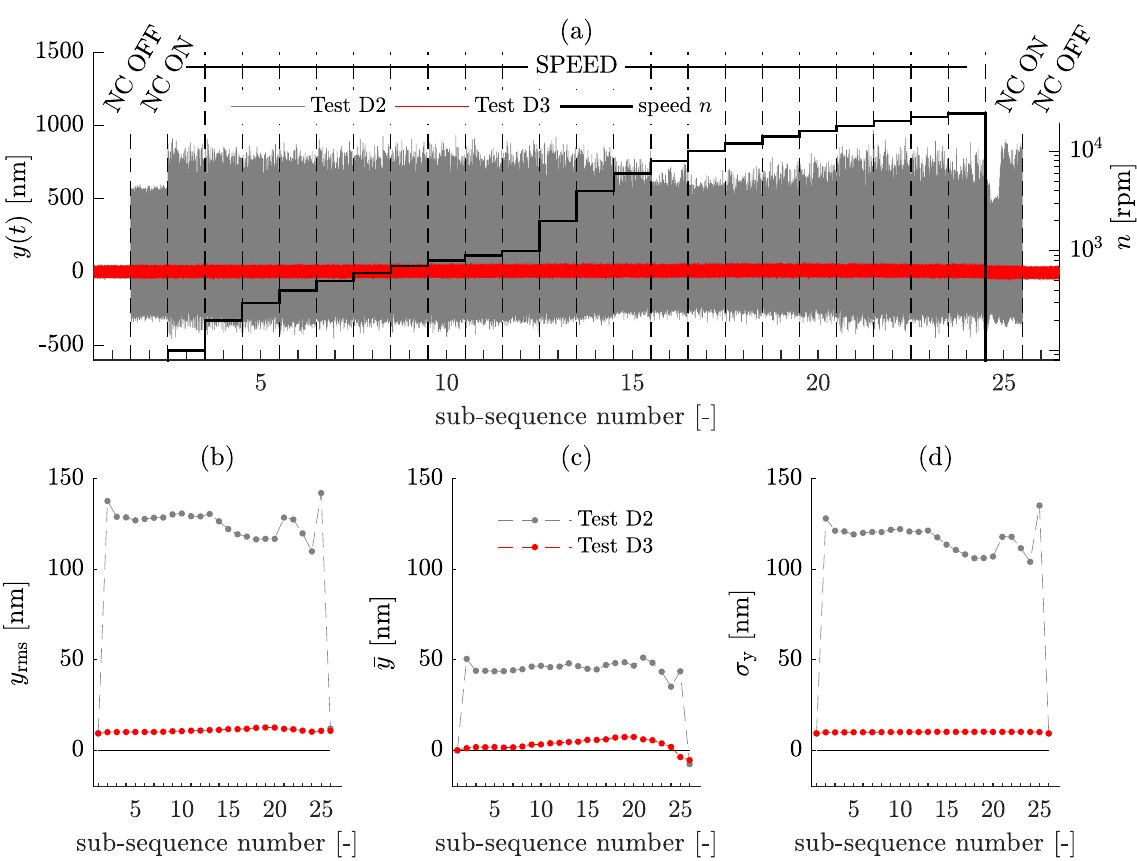
Figure 11. Comparison of electrical configurations with target coupled to spindle (Test D2 ) and electrically decoupled spindle measurement setup (Test D3 ): ( a ) signal y ( t ) in time domain (sub-sequence: time duration T = 9s and sampling frequency f s = 250kHz); ( b ) root-mean-square value y rms ; ( c ) mean value ¯ y ; and ( d ) standard deviation σ y